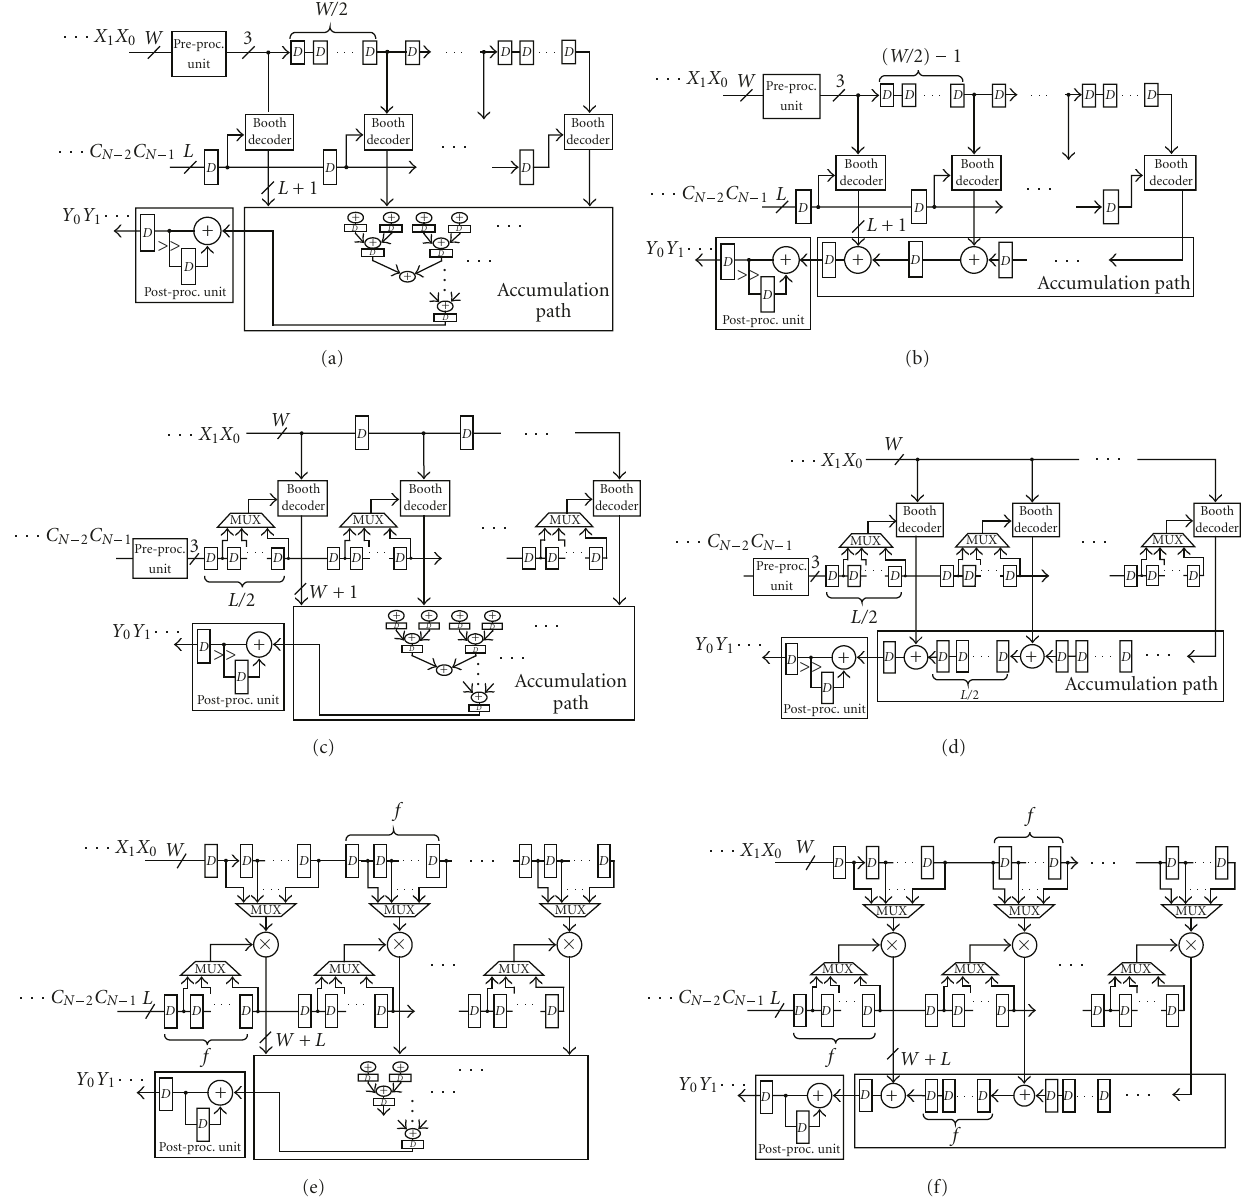
Figure 2: Six conventional FIR architectures. (a) Direct form using the input-data folding scheme. (b) Transposed direct form using the input-data folding scheme. (c) Direct form using the coe ffi cient folding scheme. (d) Transposed direct form using the coe ffi cient folding scheme. (e) Direct form using the tap-folding scheme. (f) Transposed direct form using the tap-folding